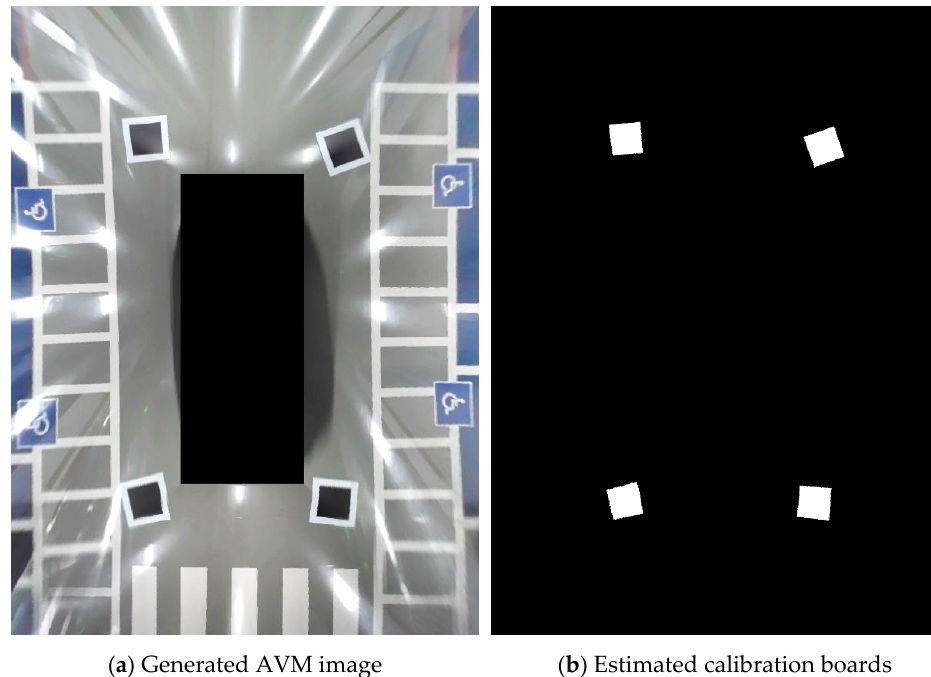
Figure 11. Example images for the performance evaluation of the proposed method.